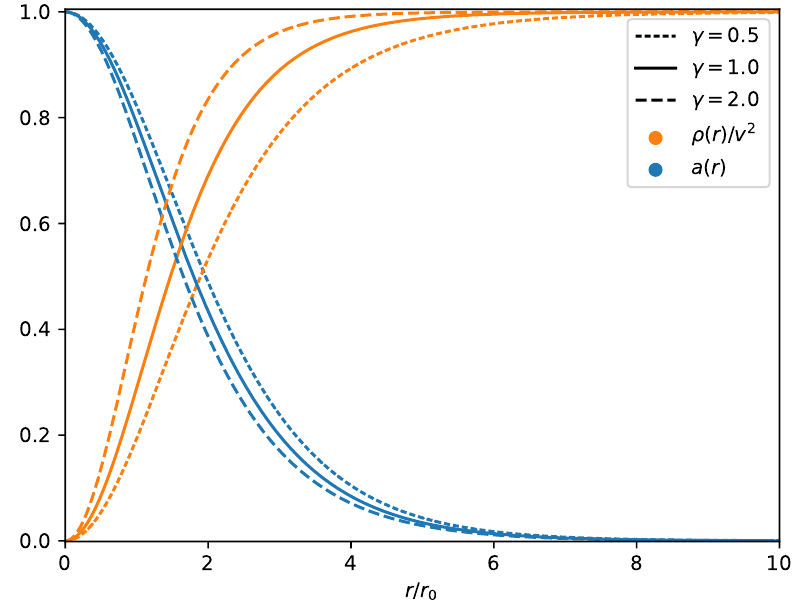
Figure 1 . Abrikosov vortex of vorticity N = 1 for different values of the coupling ratio γ = λ/ (2 e 2 ) . Some parameters have been reintroduced for